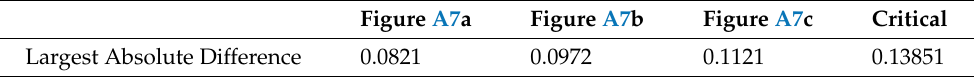
Table A4. Kolmogorov–Smirnov test results for the Monte Carlo simulations of Figure A7. Figure A7a Figure